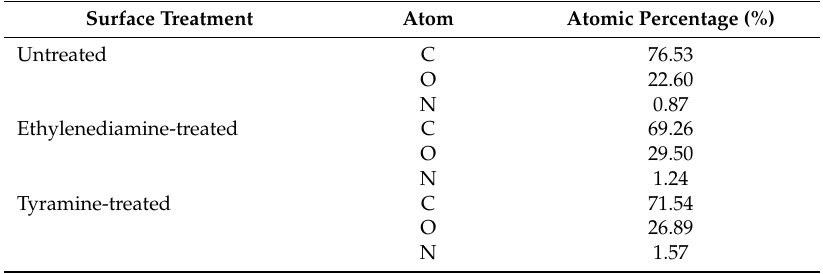
Table 3. X-ray photoelectron spectroscopy analysis of surface element composition of surface-treated bilayered PLGA scaffolds.